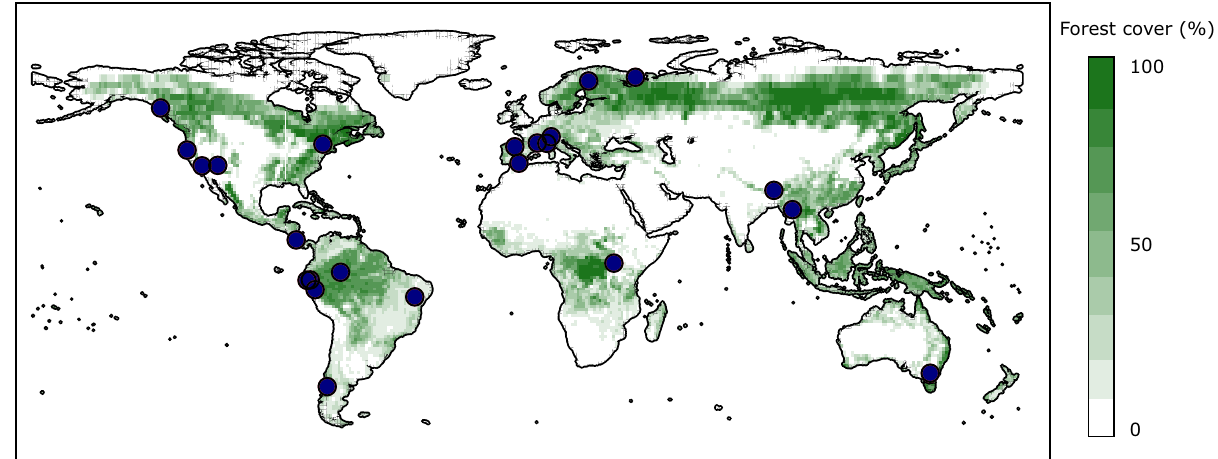
Fig. 1 Geographic distribution of the 23 studied forests. This map (image and every element) was fully created by the authors using averaged coordinates of the studied forest regions and forest cover data (public domain) retrieved in the FAO ’ s website 34